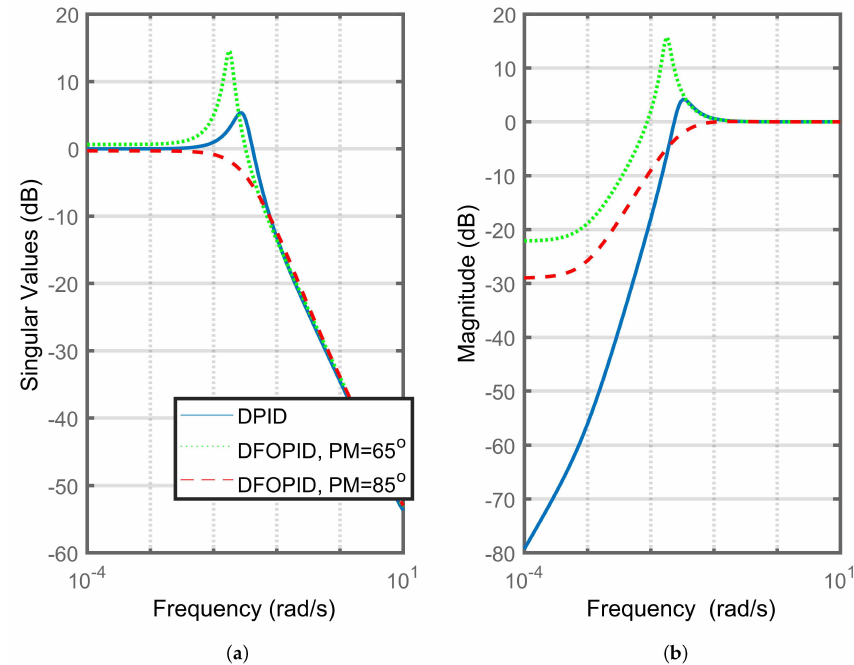
Figure 11. Frequency responses of the integer- and non-integer-order discrete PID control systems, for different phase margins (PM) φ m , T s = 0.15 s. ( a ) Singular values; ( b ) sensitivity function.